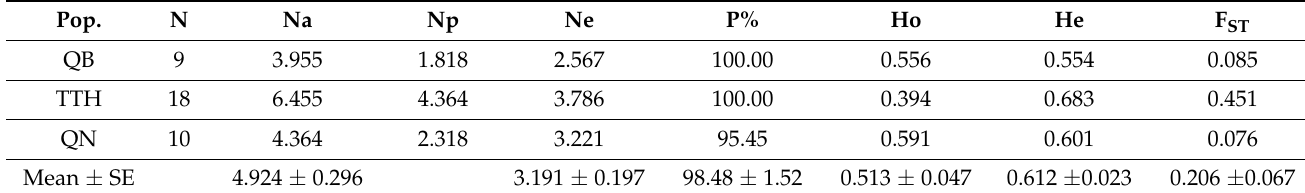
Table 10. Genetic diversity estimates of three populations of M. officinalis